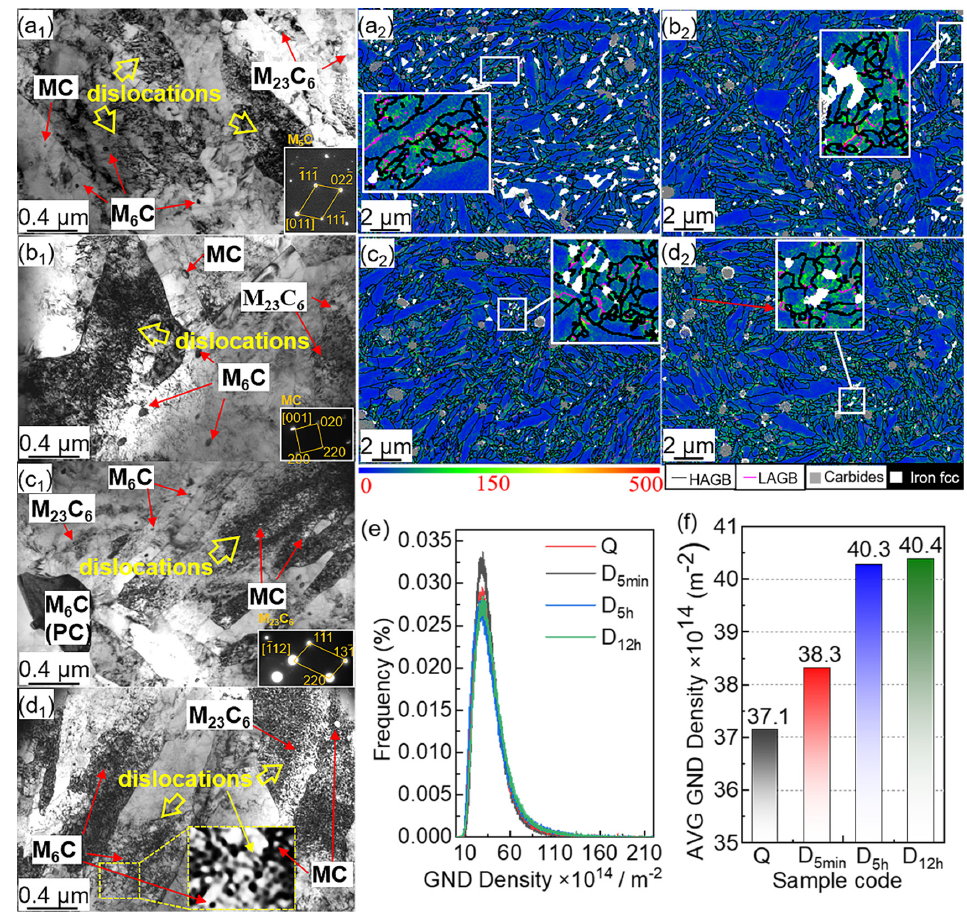
Figure 6. TEM micrographs and GND maps of ( a 1 , a 2 ) Q, ( b 1 , b 2 ) D 5min , ( c 1 , c 2 ) D 5h , and ( d 1 , d 2 ) D 12h , and ( e ) the distribution and ( f ) proportion of GND density.